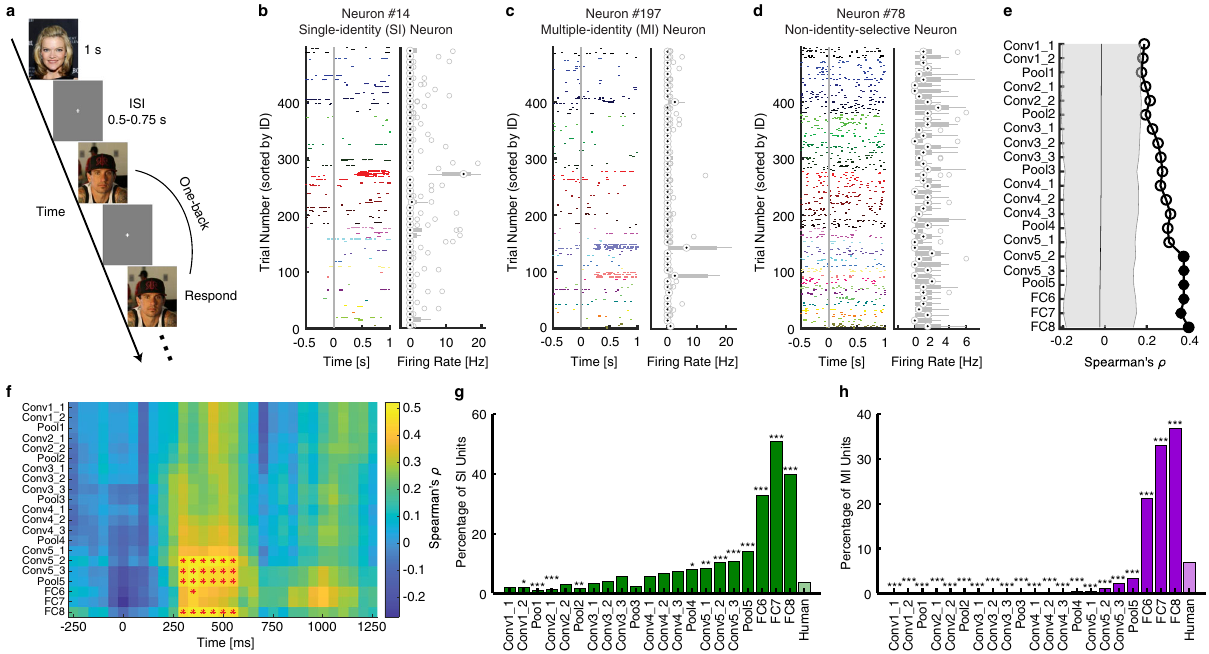
Fig. 6 Comparison between the deep neural network (DNN) units and (real) human medial temporal lobe (MTL) neurons. a Task used to acquire single-neuron responses from humans. We employed a one-back task, in which patients responded whenever an identical famous face was repeated. Each face was presented for 1 s, followed by a jittered interstimulus interval (ISI) of 0.5 – 0.75 s. b – d Neuronal responses to 500 faces (50 identities) shown in raster plots. b An example of a single-identity (SI) neuron. c An example of a multiple-identity (MI) neuron. d An example of a non-identity-selective neuron (i.e., the neuron did not encode any particular identities). Trials are aligned to face stimulus onset (gray line) and are grouped by individual identity. On each box, the central mark is the median, the edges of the box are the 25th and 75th percentiles, and the whiskers extend to the most extreme data points the algorithm considers to be not outliers. e Correlation between pairwise distance in the human MTL neuronal face space and pairwise distance in the DNN face space. Here, we used the mean fi ring rate in a time window 250 – 1000ms after stimulus onset as the response to each face, and we averaged the responses to 10 faces for each face identity. We calculated the correlation using the top ten identities that were most frequently encoded by MTL neurons. Solid circles represent a signi fi cant correlation (permutation test: P < 0.05, corrected by false discovery rate (FDR) 35 for Q < 0.05) and open circles represent a non-signi fi cant correlation. The shaded area denotes ±SD across permutation runs. f Temporal dynamics of correlation of pairwise distance between human neurons and DNN units (bin size = 500 ms, step size = 50 ms). Color coding indicates Spearman ’ s correlation coef fi cient. Asterisks (*) indicate a signi fi cant correlation in that bin (permutation test: P < 0.05, FDR corrected across time bins for each layer). g Percentage of SI units in each DNN layer and comparison with SI neurons from the human MTL. h Percentage of MI units in each DNN layer and comparison with MI neurons from the human MTL. Asterisks indicate a signi fi cant difference in the percentage using χ 2 -test with Bonferroni correction for multiple comparisons. * P < 0.05, ** P < 0.01, and *** P <